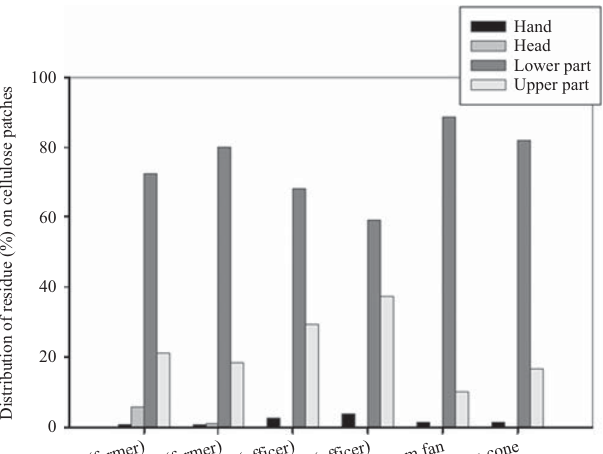
Figure 1. Extrapolation of residues on cellulose patches to surface contamination of body parts according to OECD guidelines (on rice at the tillering